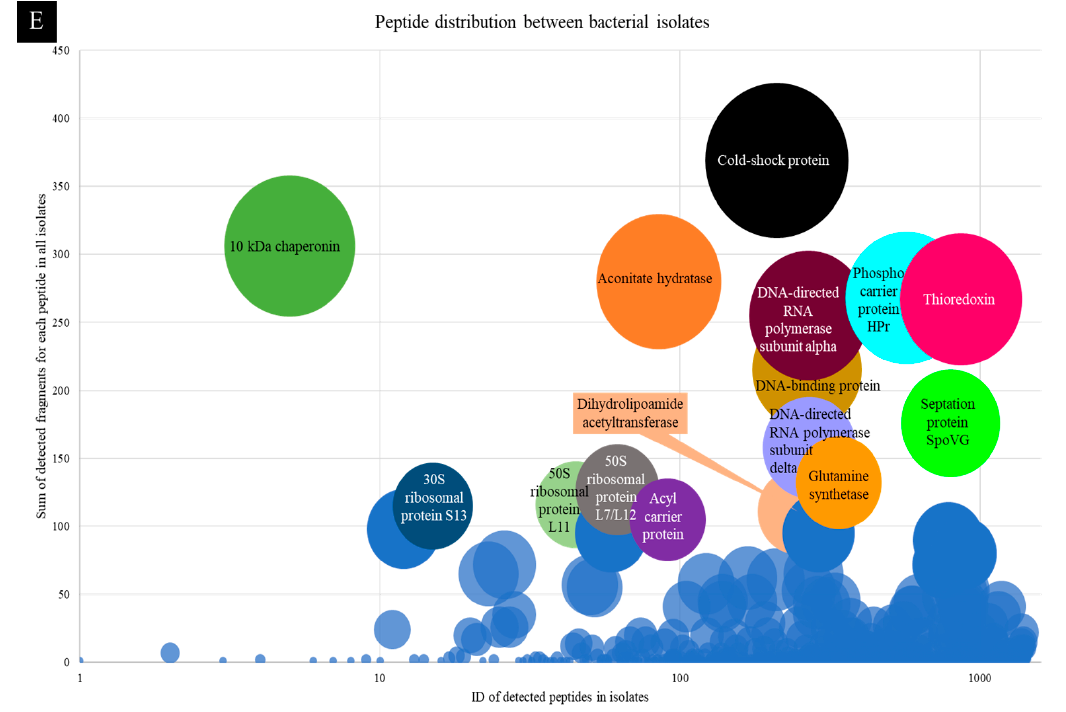
Figure 2. Antimicrobial peptide analysis. Top: Electrophoresis of bacterial supernatants on Tris–Tricine gels. ( A , B ) One half of the gel containing bioactive supernatants of the isolates 32YE and 9th, respectively, was challenged with C. michiganensis as a “gel plate assay” and the other half of the gel, with identical samples, was stained with Coomassie Brilliant Blue. ( C , D ) Gel plate assay of the isolates 33YE or 32LM, respectively, tested against L. monocytogenes and its half-stained gel with identical samples to visualize and recover the protein band(s) for further characterization by MS/MS. ( E ) MS/MS data from all peptides and protein fragments’ excised bands from all isolates (Supplementary File S6, Table S1). CS: crude supernatant; OP: organic phase; AP: aqueous phase; L: protein standard.